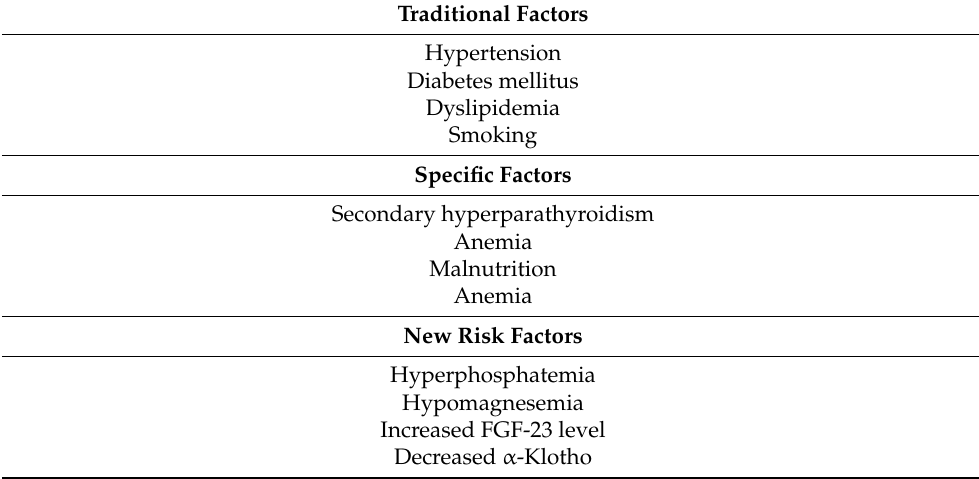
Table 1. Incriminated factors in the onset of uremic cardiomyopathy [82].